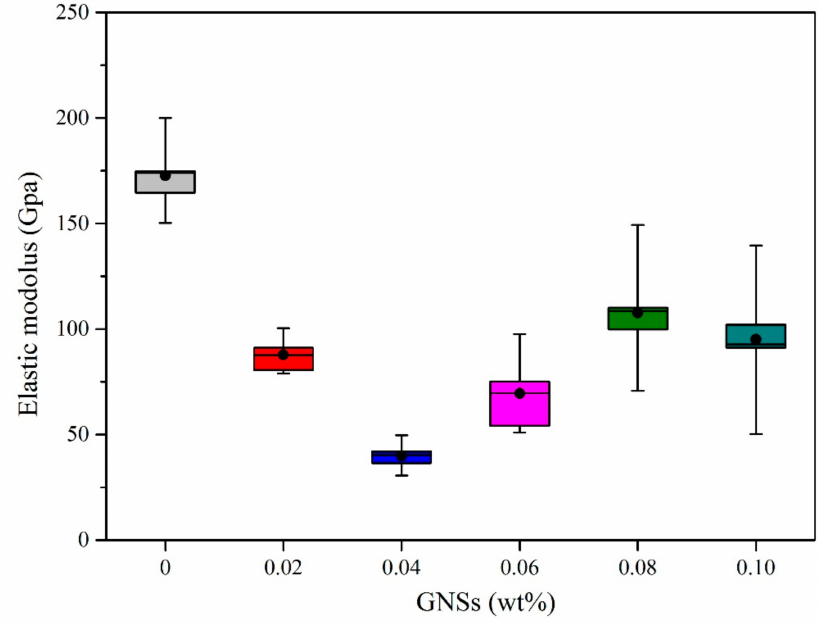
Figure 9. Elastic modulus of IMCs at solder / Cu interface with various GNS